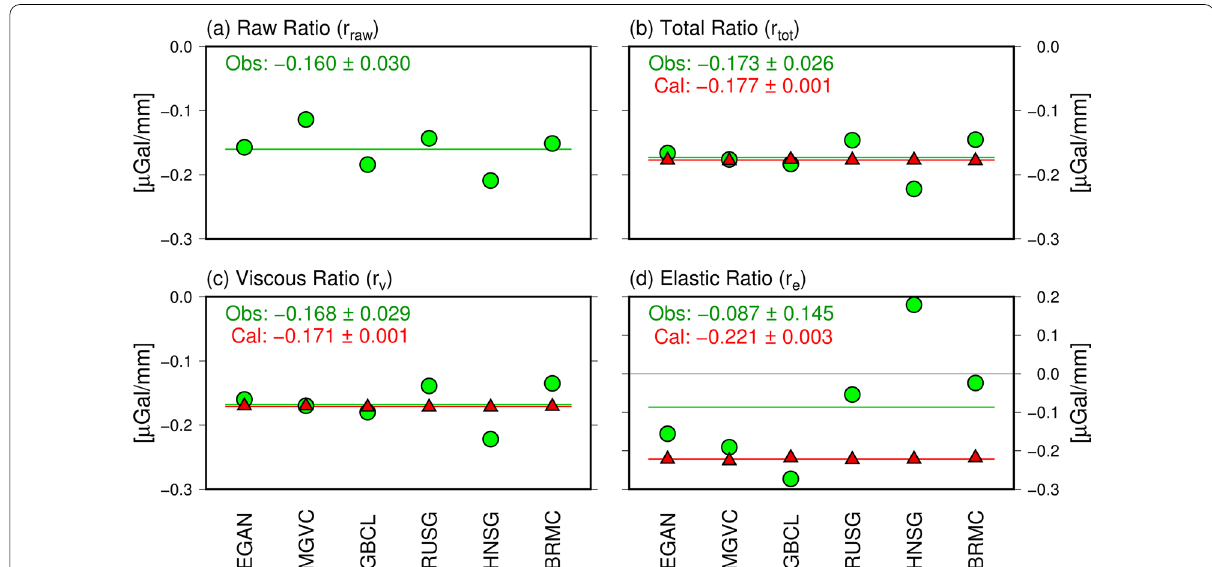
Fig. 11 Ratio of gravity variation to vertical ground deformation at six AG points. Green circles and red triangles indicate the ratio values obtained from the observation data and calculated results, respectively. Green and red lines indicate the average values of the observed and calculated ratios, respectively, and these average values are shown on the top left of each panel. a Raw ratio. b Total ratio. c Viscous ratio. d Elastic